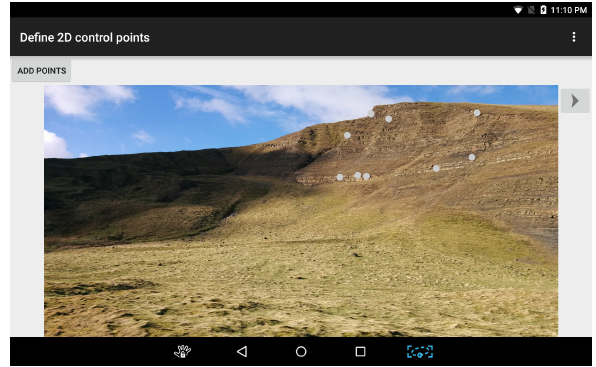
Figure 1: The manual registration interface, defining 2D correspondence points (grey circles) within the photograph, captured via smartphone.